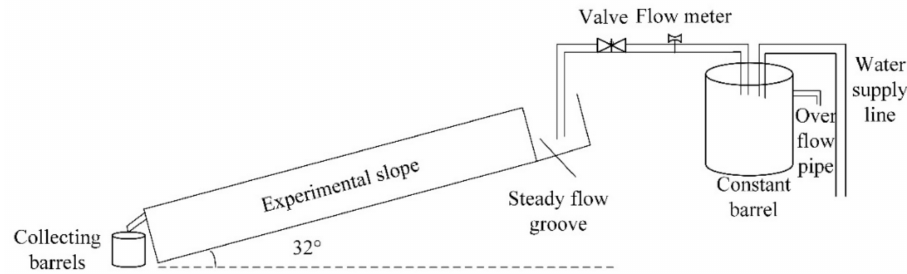
Figure 2. Layout of the field scouring experimental